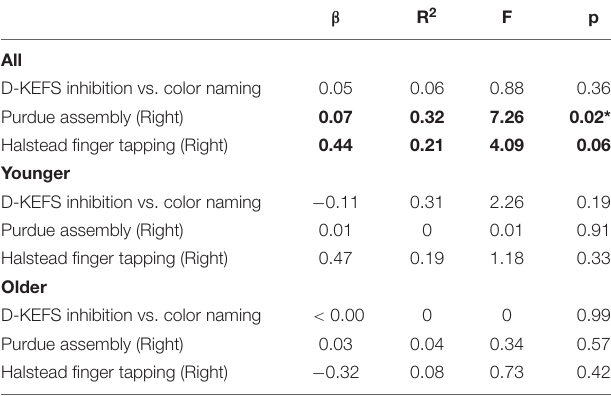
TABLE 5 | Linear regression of behavioral measures with